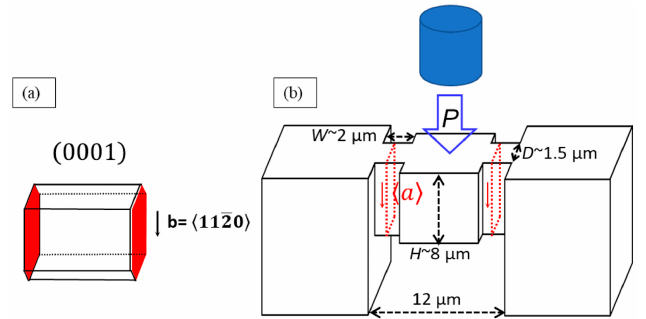
Figure 8. ( a ) A schematic of the shear plane and the shear direction of single crystal magnesium; ( b ) the geometry of single crystal magnesium under microshear [90].